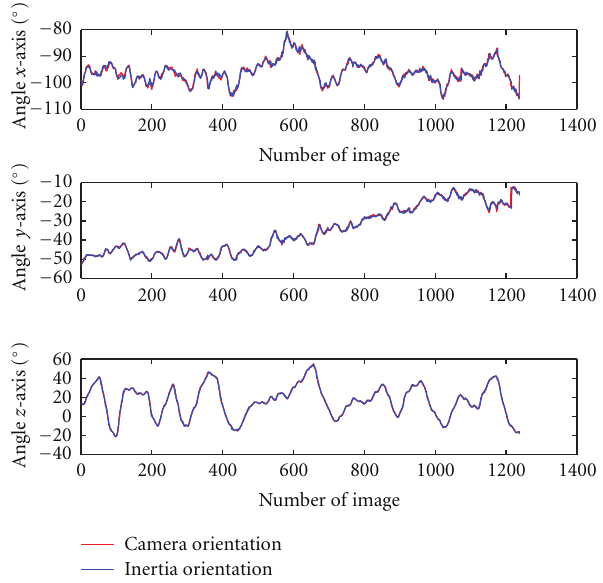
Figure 14: The camera’s orientation versus inertial sensor’s orien-